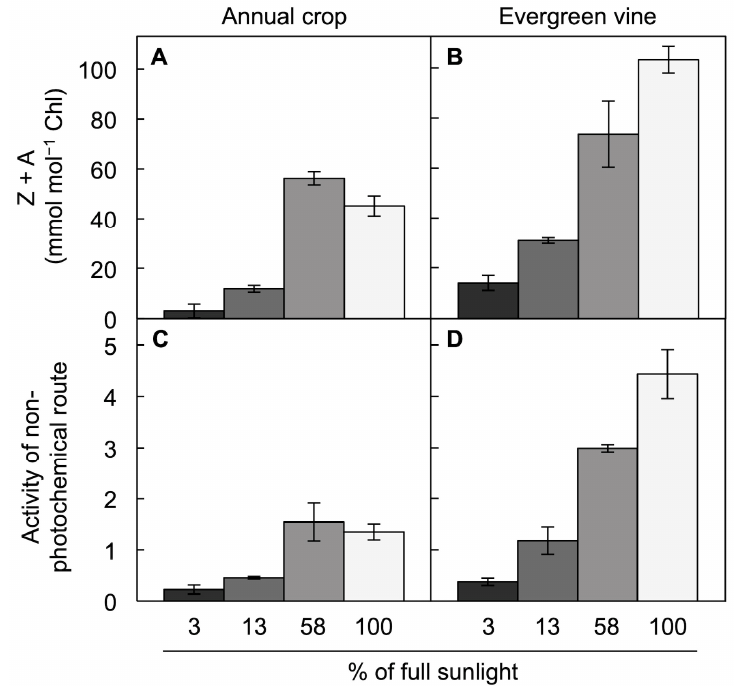
Figure 9. Foliar levels of ( A , B ) zeaxanthin + antheraxanthin (Z + A) per chlorophyll (Chl) and ( C , D ) energy dissipation via the non-photochemical route (quantified from chlorophyll fluorescence as Stern–Volmer quenching) at midday during the summer in the herbaceous annual pumpkin ( A , C ) and the evergreen groundcover Vinca major ( B , D ). Plants were grown in the field under a shade cloth, resulting in penetration of 3% of full sunlight (black columns), 13% of full sunlight (dark gray columns), or 58% of full sunlight (medium gray columns), or with no shade cloth (100% or full sunlight; light gray columns). Mean values ± standard deviations, n = three leaves. Data are from Logan et al.